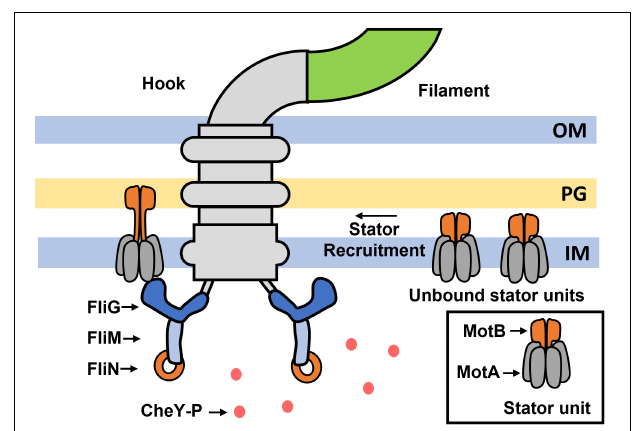
FIGURE 1 | The flagellar motor. Major parts of the flagellar motor are indicated. Unbound stator units diffuse in the membrane and reversibly bind to the motor to induce rotation. The motor recruits additional stator units when the resistance to its rotation is increased (Lele et al., 2013). The FliG ring within the rotor interacts with the stator units, and its conformation determines the direction of rotation. Freely diffusing CheY-P binds to the FliM and FliN complexes located beneath the FliG ring to promote conformational changes in